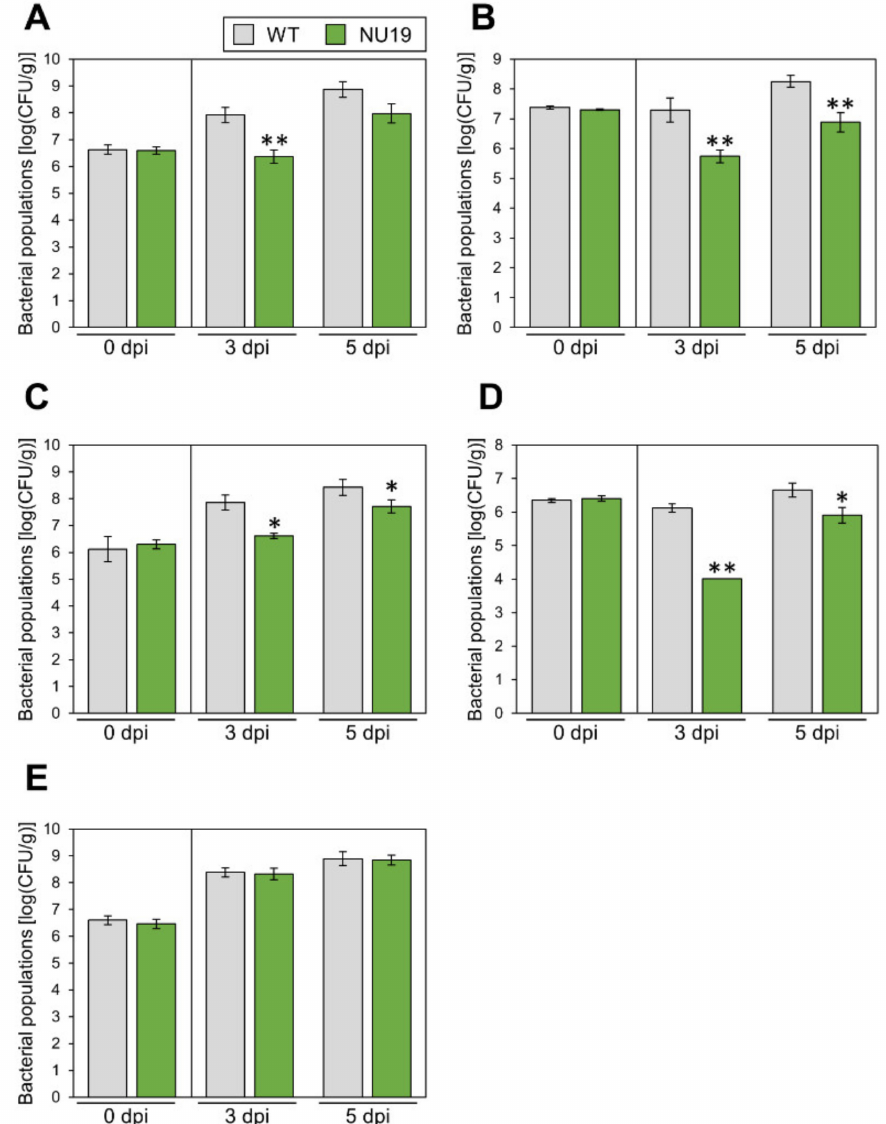
Figure 4. Bacterial populations of Pseudomonas cannabina pv. alisalensis KB211 WT and NU19 in brocolli ( A ), Japanese radish ( B ), Chinese cabbage ( C ), tomato ( D ), and oat ( E ). All plants were dip-inoculated with 5 × 10 7 CFU/mL of inoculum containing 0.025% Silwet L-77. The bacterial populations in the plant were evaluated at 0, 3, and 5 dpi. Vertical bars indicate the standard error for at least three independent experiments. Asterisks indicate a significant difference from the Pcal WT in a t -test (* p < 0.05, ** p <